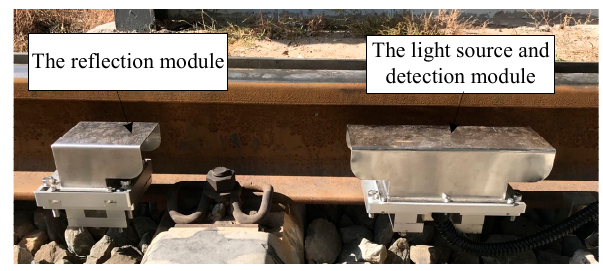
Figure 18. The field installation of the wheel flat detection system.